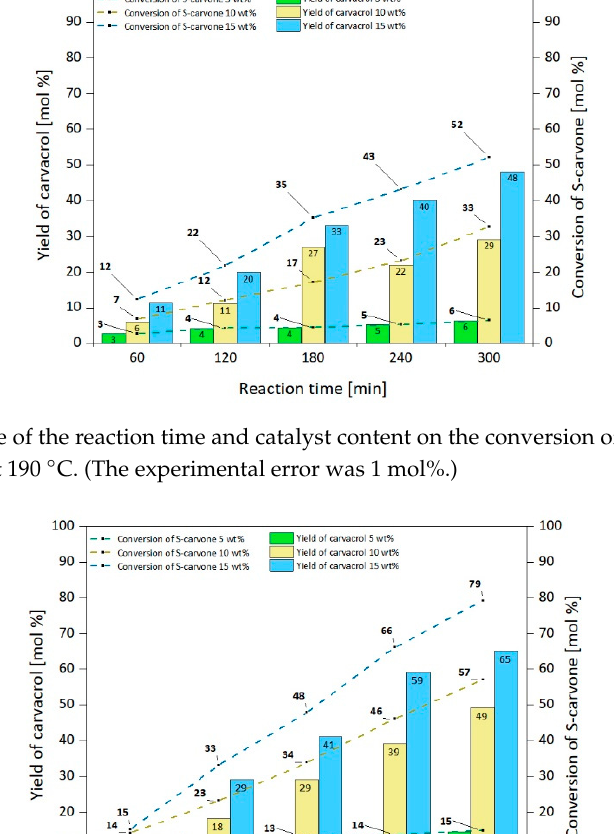
Figure 13. Influence of the reaction time and catalyst content on the conversion of S-carvone and the yield of carvacrol at 190 °C. (The experimental error was 1 mol%.)